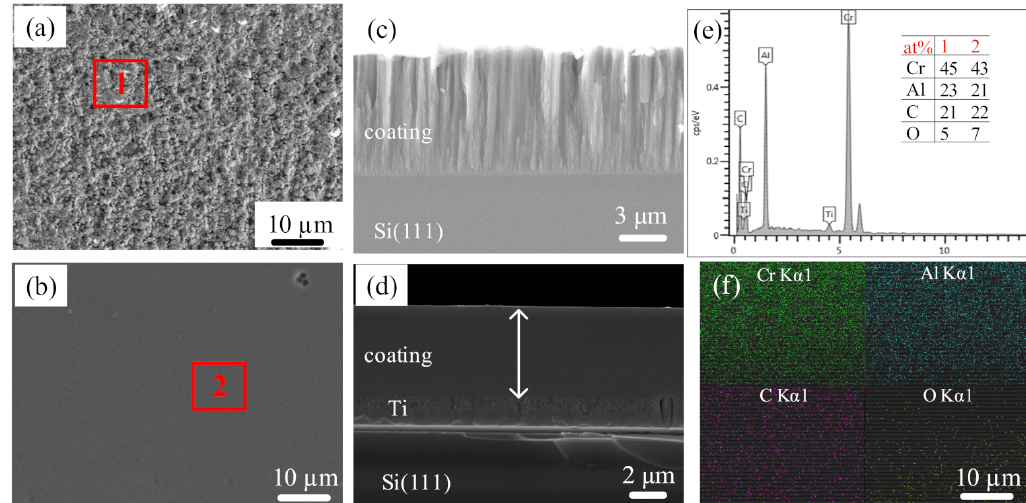
Figure 5. Surface and cross-sectional morphology of the Cr 2 AlC coatings deposited by ( a ), ( c ) conventional DCMS ( p = 112 W) without a Ti buffer layer and ( b ), ( d ) HiPIMS (P ave = 110 W) with a Ti buffer layer; ( e ) EDS spectrum and quantification results of red points in ( a , b ); and ( f ) EDS elemental mapping of ( b ). Quantification error within